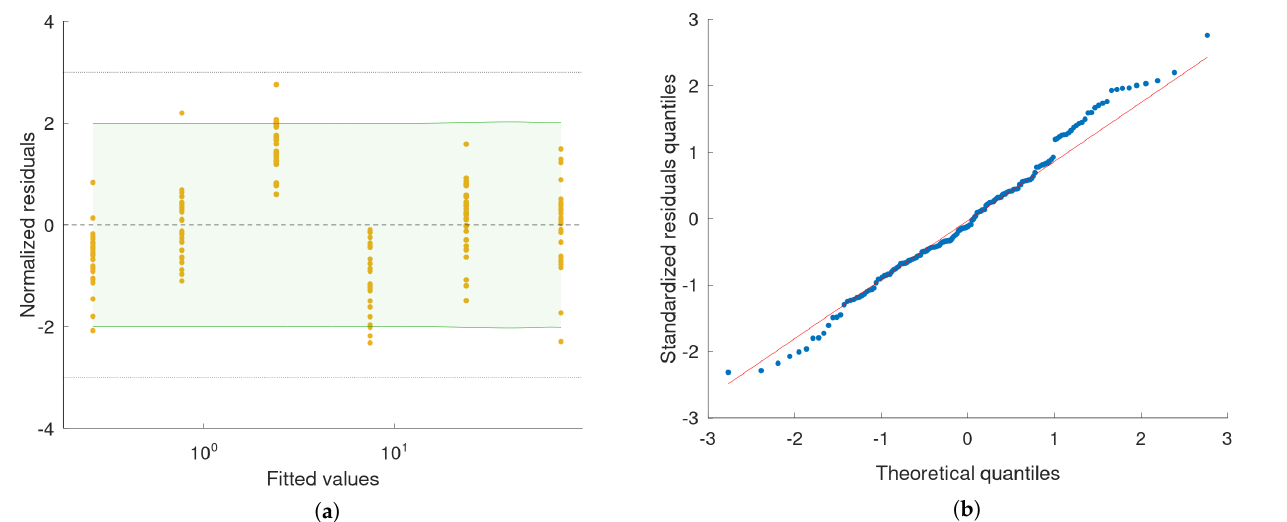
Figure 11. ( a ) Scatter plot of the normalised residuals (residuals divided by the standard deviation, σ = 15.1 nm) vs. fitted values from the quadratic regression model. Shapiro–Wilk test for nor- mality of residuals distribution: p = 0.18. Dashed lines indicate the ± 3 σ zone. The green–shaded area represents the 95% prediction interval for a new observation based on the obtained model.